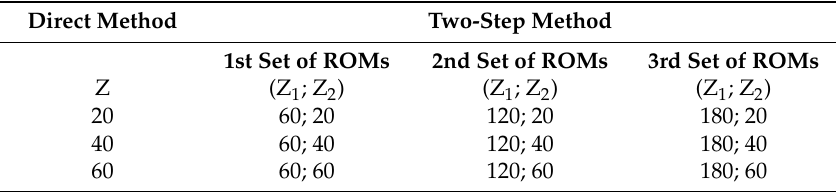
Table 2. List of ROMs generated and used for comparison.